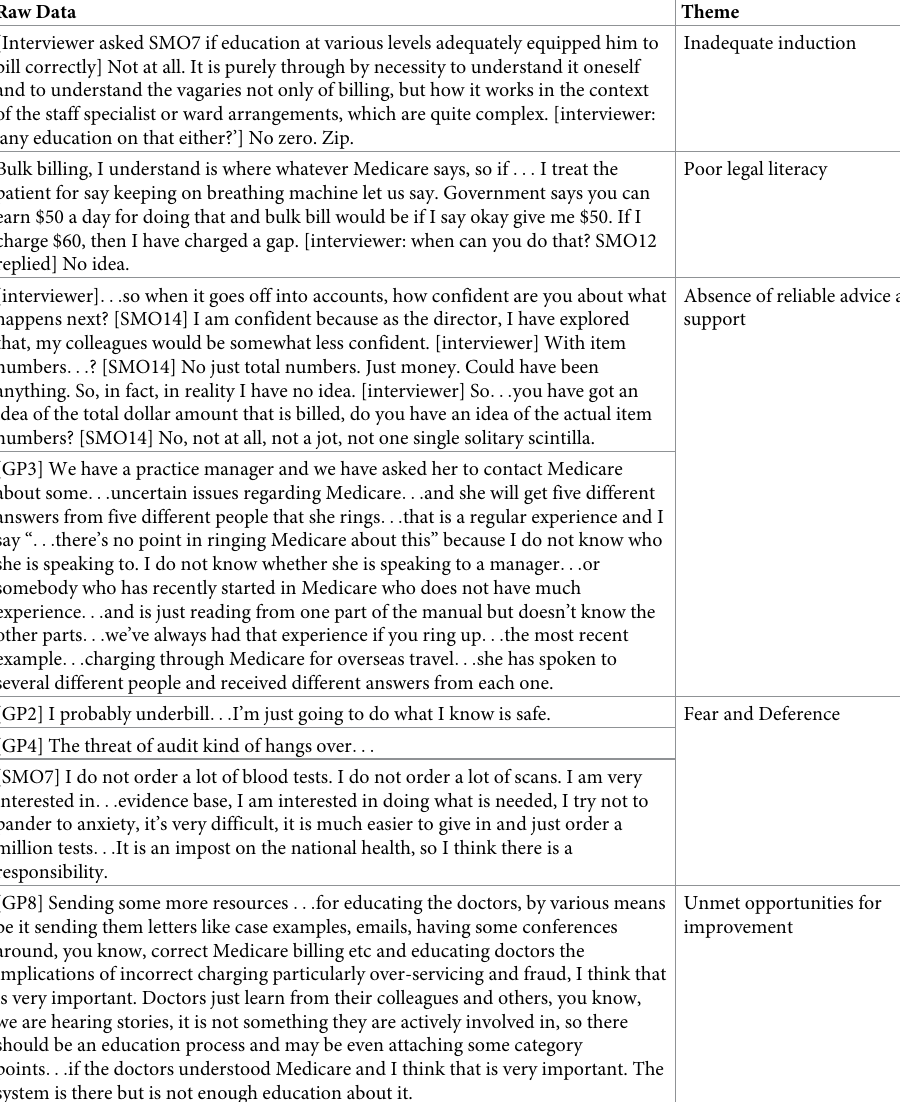
Table 1. Example of raw data